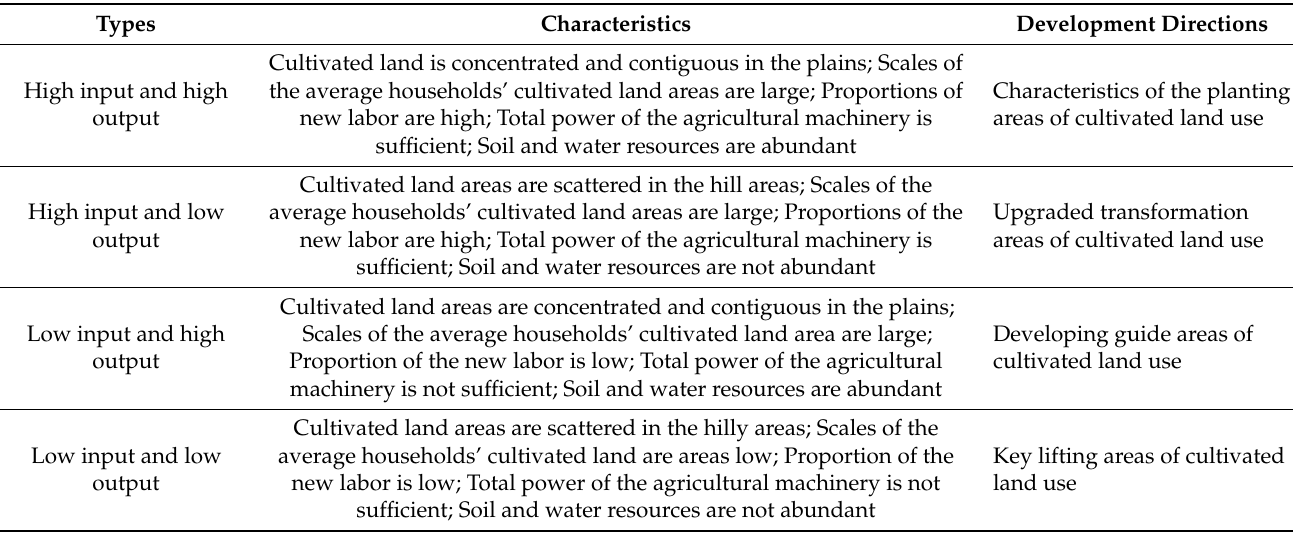
Table 2. Types and directions of the VCLUI in Baiquan